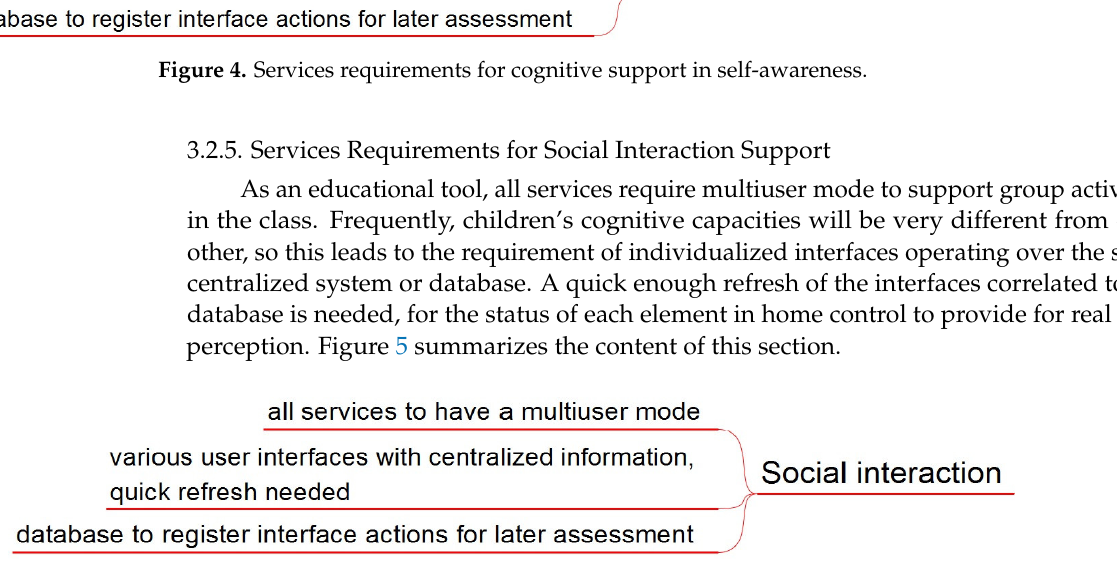
Figure 5. Services requirements for cognitive support in social interaction.